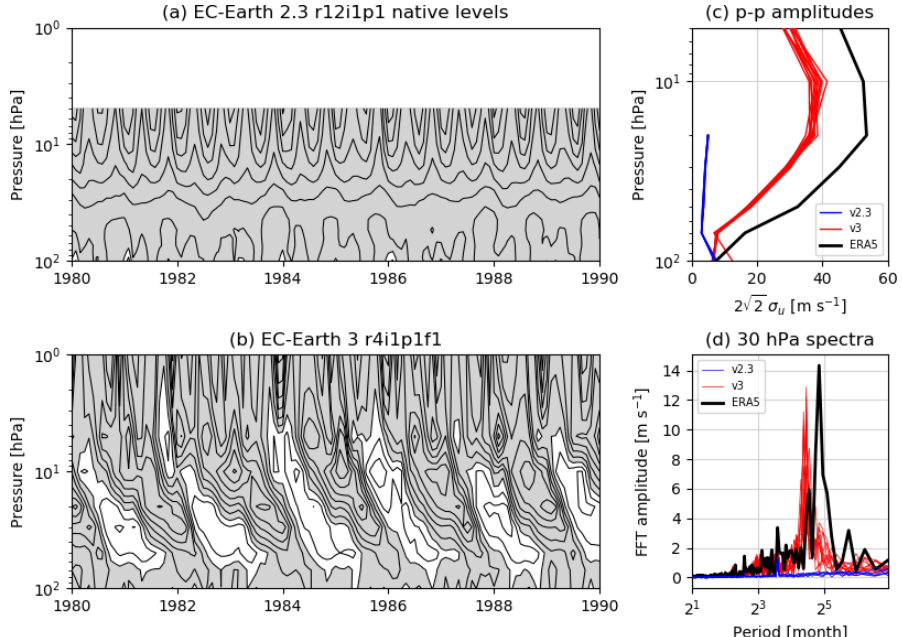
Figure 21. 10 years of the equatorially (within 5 ◦ from the Equator) averaged monthly mean zonal wind in EC-Earth2.3 (r12i1p1, a ) and EC-Earth3 (r4i1p1f1, b ) as a function of time and altitude. Easterly winds are shaded in gray, and the contour interval is 5ms − 1 . The peak-to-peak amplitude profiles of the equatorial zonal wind, estimated from the temporal standard deviation for the period 1980–2010, are reported in (c) for ERA5 (black), 12 CMIP6 (red), and 6 CMIP5 (blue) ensemble members. In panel (d) the Fourier spectra at the 30hPa level for ERA5 (black) and the same experiments in panel (c) are shown. Only for panel (a) are the results for EC-Earth2.3 interpolated onto pressure levels from native model